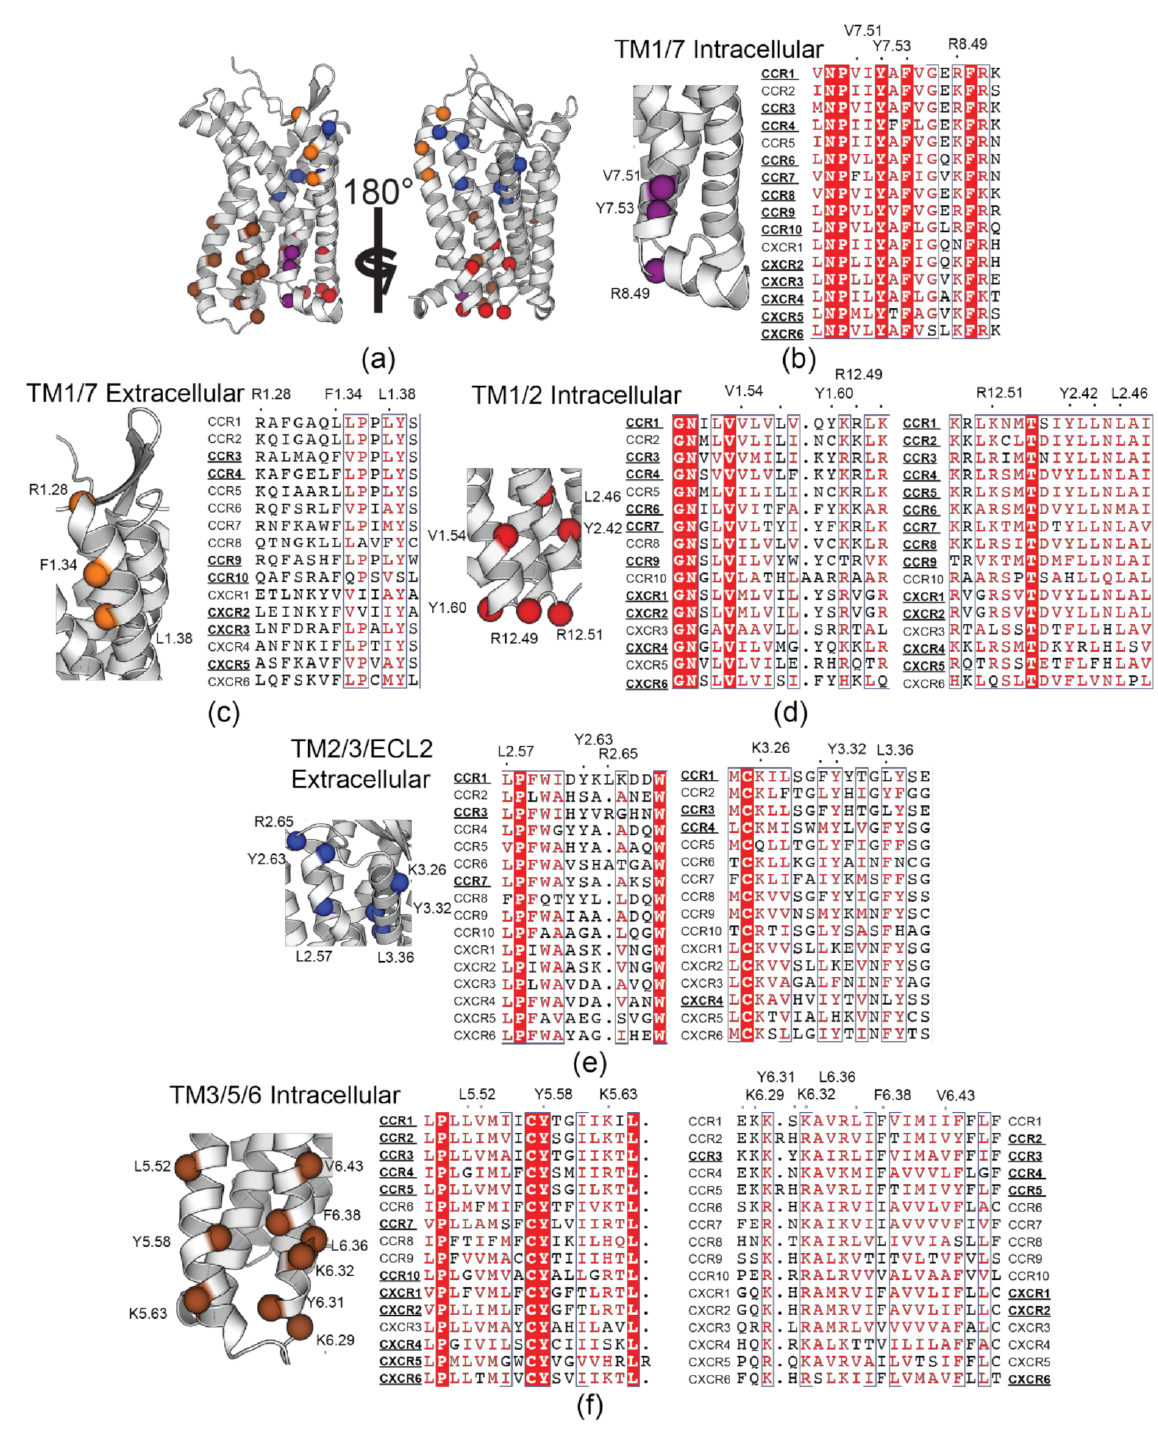
Figure 6. Conservation of CCR3-identified Cholesterol Recognition/Interaction Amino Acid Consensus motif (CRAC) and its inversion (CARC) motifs in other CC and CXC chemokine receptors. ( a ) Overview of CRAC/CARC residues in Pylipid-predicted binding sites, zoomed and aligned in ( b ) TM1/7 intracellular side, ( c ) TM1/7 extracellular side, ( d ) TM1/2, ( e ) TM2/3/ECL2, and ( f ) TM3/5/6. Each residue is color coded by which binding site it resides in. Residues above alignments indicate the CCR3 residue in the CRAC or CARC motif and its position according to the Weinstein–Bellesteros numbering convention [87]. Dots near labeled residues represent other amino acids that could feasibly satisfy the cholesterol motif sequence. Bolded and underlined receptor names indicate conservation of the motif in the receptor, though the residue position may fluctuate. In ( f ), there are two motifs in TM6 (right). Bolded and underlined receptors on the left of the alignment indicate the site containing Y 6.31 , while the right contains F 6.38